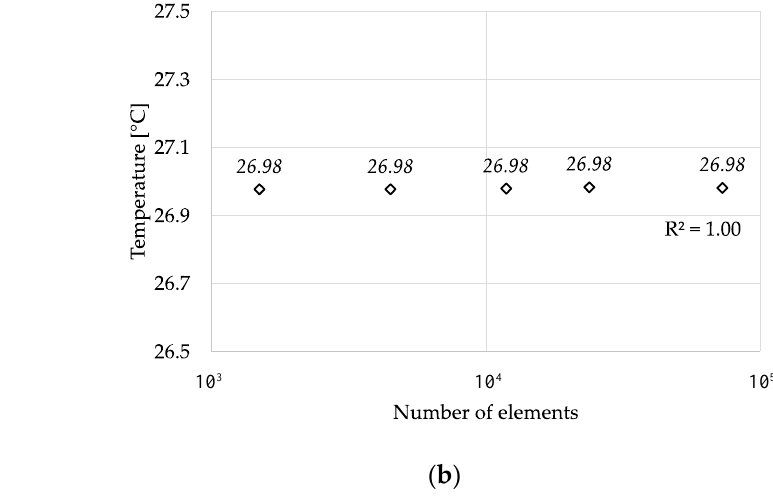
Figure 9. ( a ) Nomenclature and position and the sensors defined in COMSOL Multiphysics; ( b ) verification of the mesh independence of the wall model.